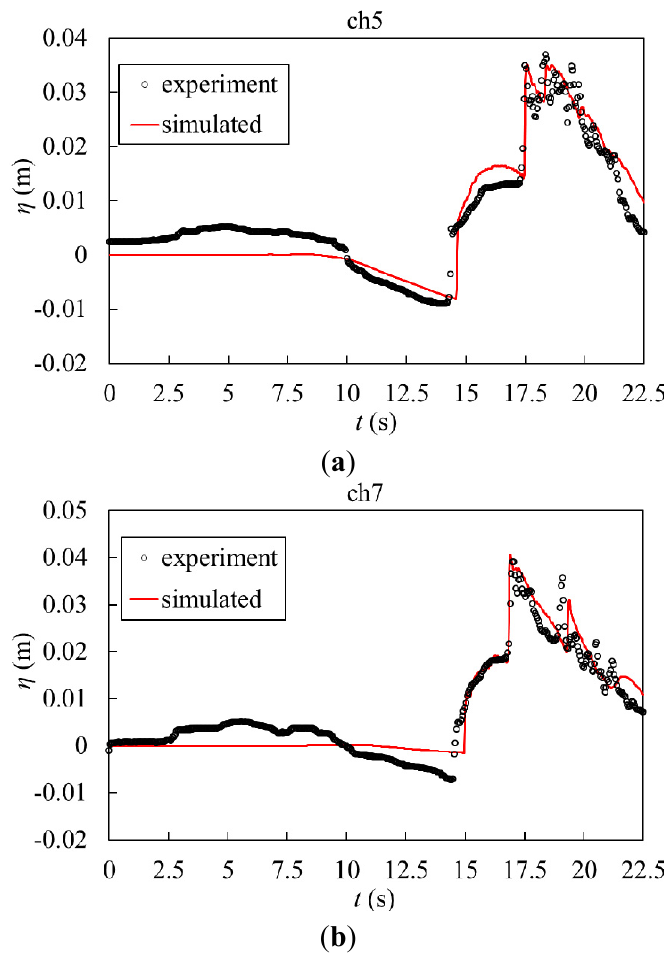
Figure 4. The simulated inundation map at different times in a 3D view. Numerical results of water depth are presented in the colored contours, while grey color represents bed elevation. ( a – f ) represent water depth at the simulation times of 10 s, 12 s, 14, 16, 17 s, and 18 s,